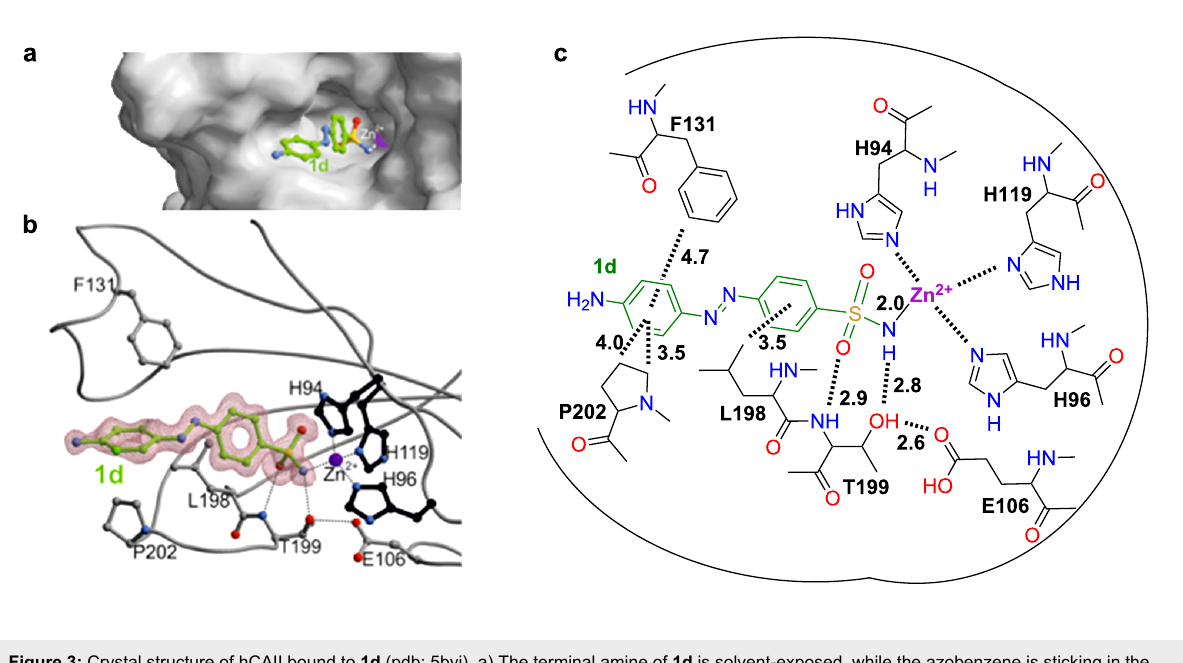
Figure 3: Crystal structure of hCAII bound to 1d (pdb: 5byi). a) The terminal amine of 1d is solvent-exposed, while the azobenzene is sticking in the cavity. b) Electron-density map of 1d bound to zinc with primary interactions. c) Interactions of 1d in the catalytic site in angstroms (Å). Primary inter- actions of the zinc-bound sulfonamide can be seen to T199 and L198 to the aromatic core. Secondary interactions can be observed from F131 and P202 towards the second aromatic ring of the